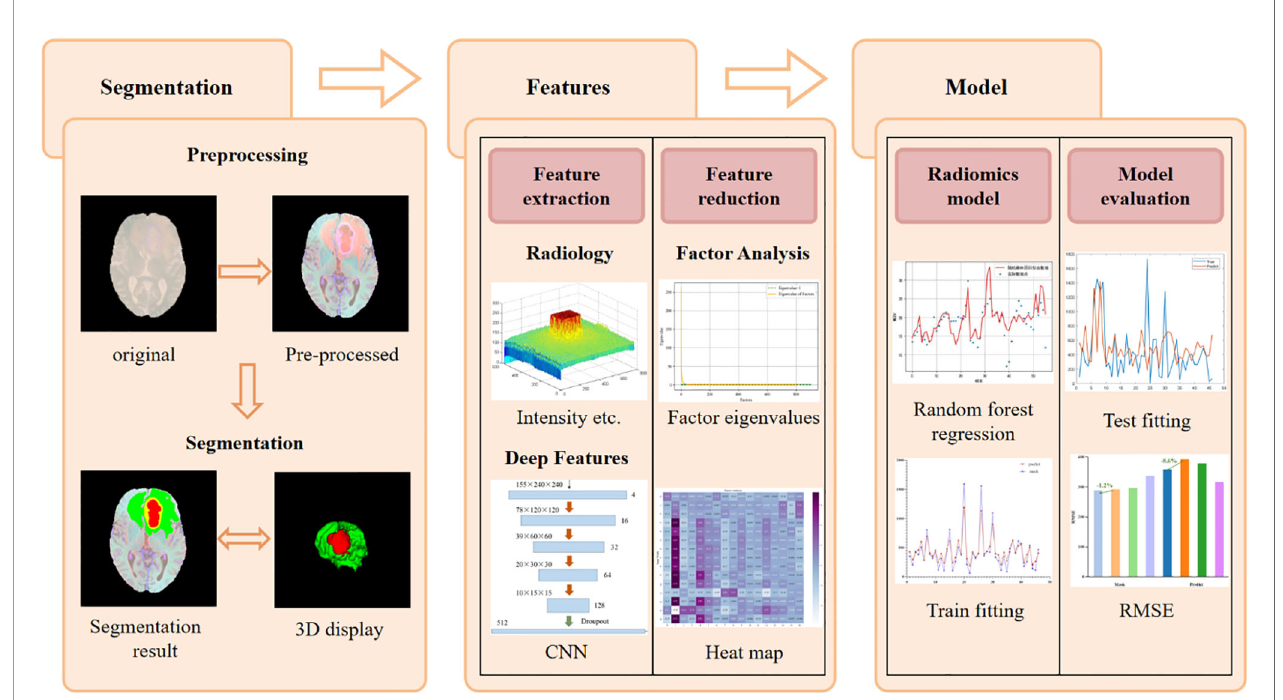
FIGURE 1 | Flow chart of brain tumor segmentation and overall survival